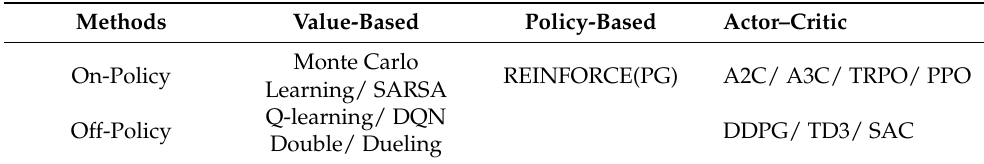
Table 2. Categories of different RL algorithms.